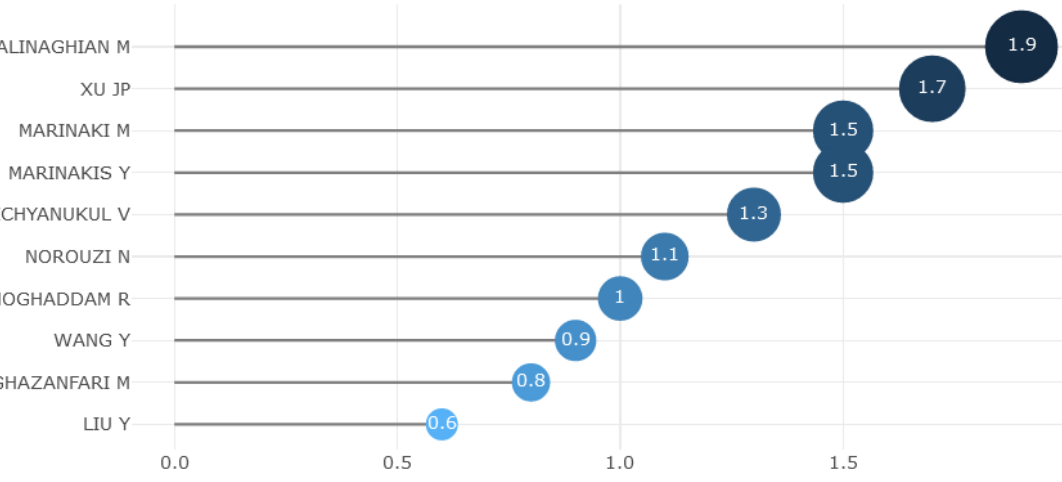
Figure 5. Most relevant authors for Web of Science PSO/VRP publications, by number of publications (fractionalized).